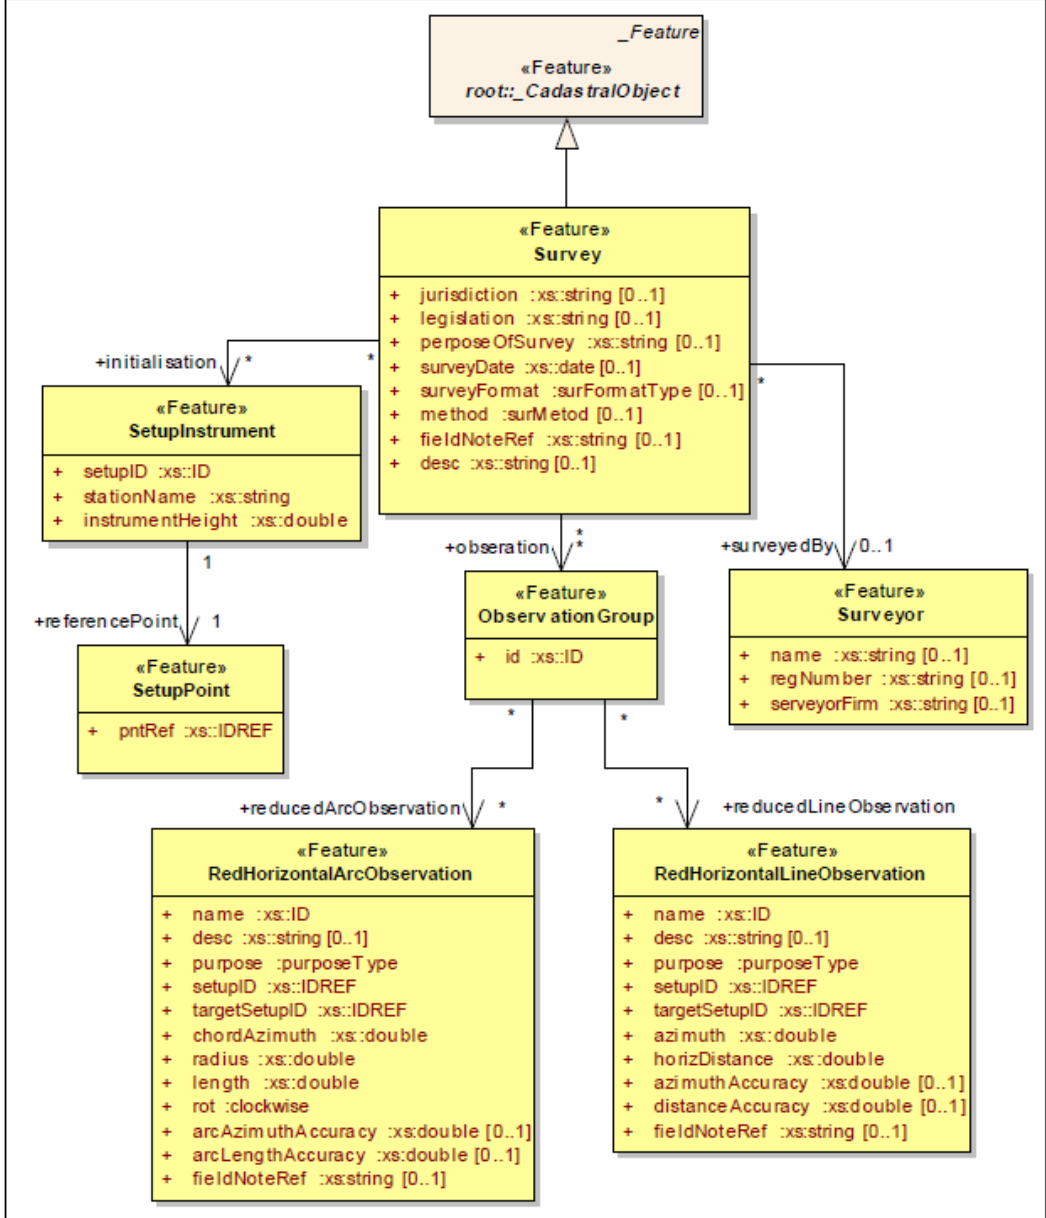
Figure 15. The UML diagram of 3DCDM Survey